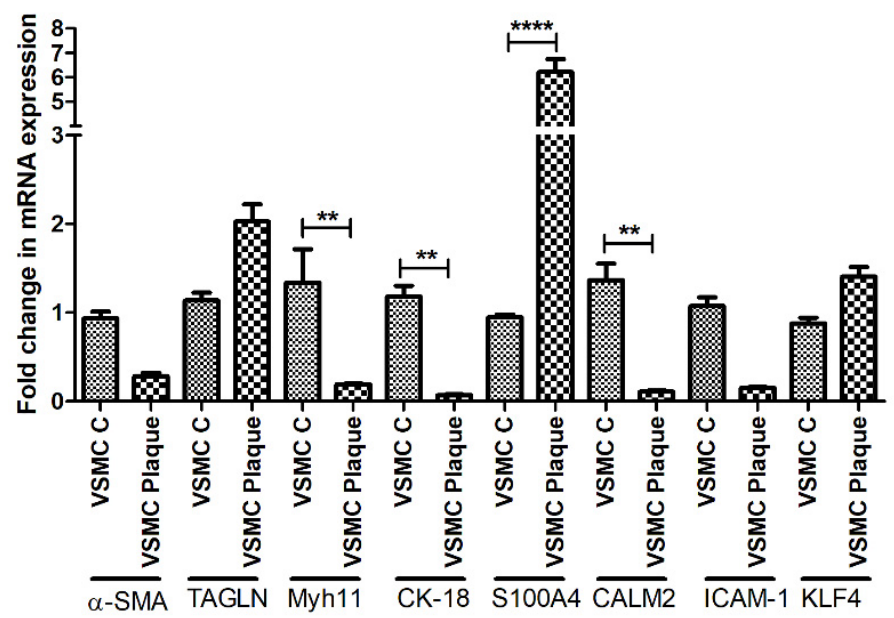
Figure 3. RT-qPCR data for VSMCs phenotype markers in VSMCs isolated from control and arteries with plaque. Alpha-smooth muscle actin ( α -SMA), transgelin (TAGLN), Myosin Heavy Chain 11 smooth muscle (Myh11), cytokeratin (CK)-18, S100 protein A4 (S100A4), calmodulin 2 (CALM2), Intercellular Adhesion Molecule (ICAM)1, Krüppel-like factor 4 (KLF4). α -SMA, TAGLN, and Myh11 (markers for contractile vascular smooth muscle cells (VSMCs)); CK-18, S100A4, CALM2, and ICAM1 (markers for proliferative VSMCs); and KLF4 (a marker for de-differentiated VSMCs). All data are presented as mean ± standard deviation (SD). p < 0.05 is considered statistically significant. ** p < 0.01 and **** p <